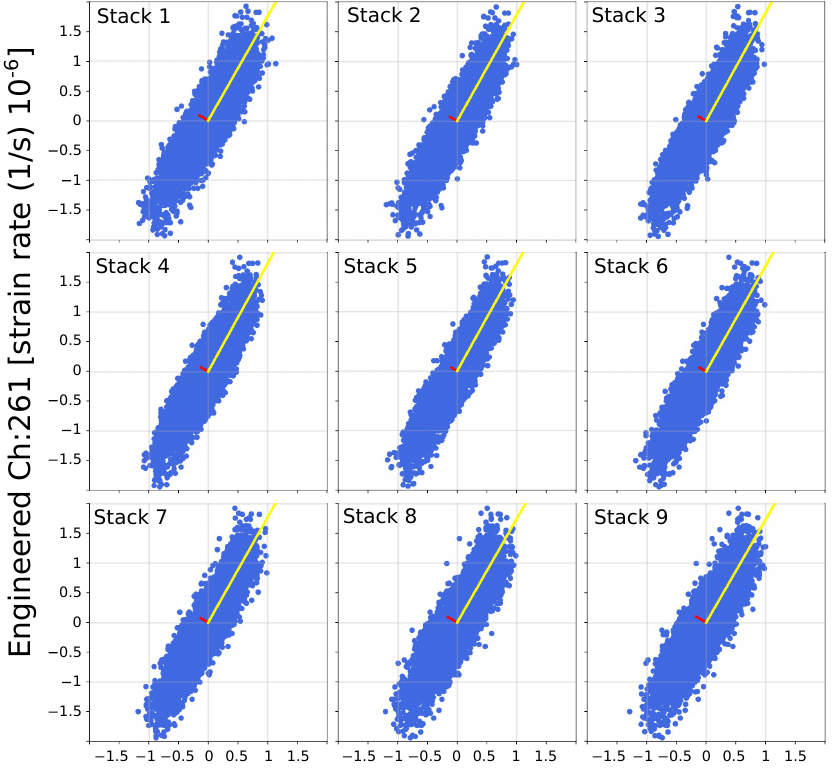
Figure 7. Strain-rate cross-plots between the stack instances of the standard fibers and engi- neered fiber amplitudes using the equivalence of channels 336 (standard) and 261 (engineered). The yellow and red lines indicate the direction of the eigenvectors instance vs. engineered amplitude comparison,